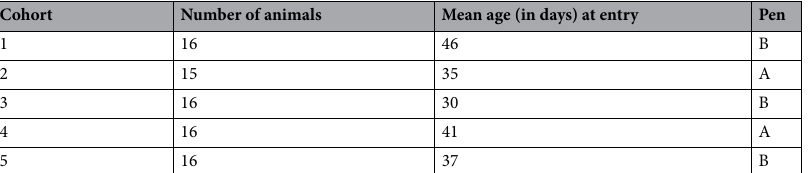
Table 1. Characteristics of each cohort for this study with number of animals per cohort, mean age (in days) at entry and pen location. Mean age was rounded to the nearest integer.